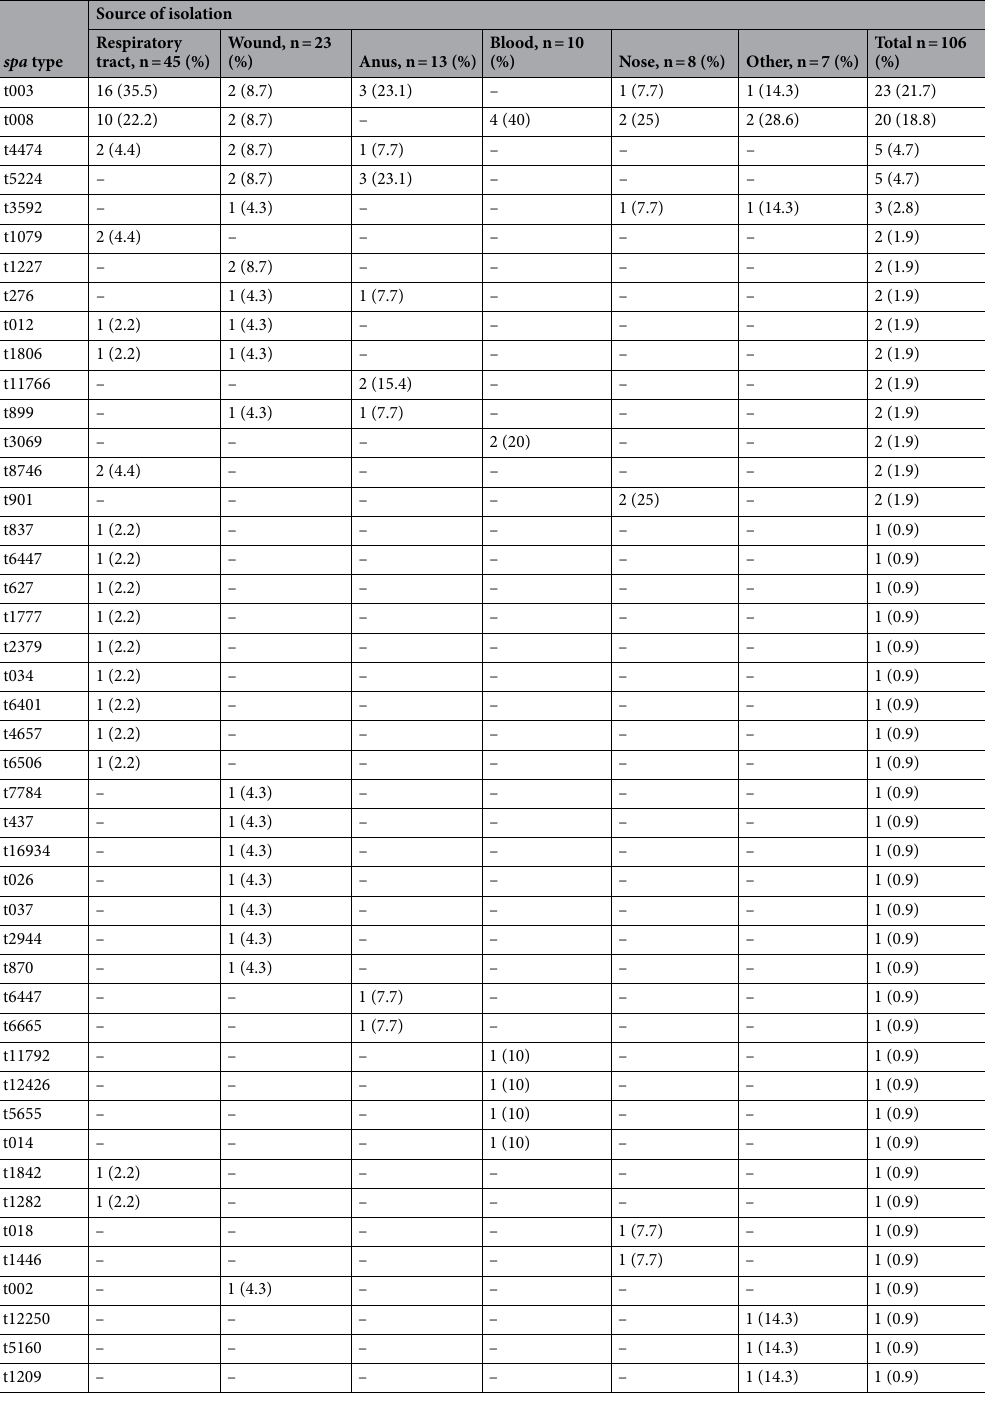
Table 4. Occurrence of the spa types among MRSA isolates from different clinical